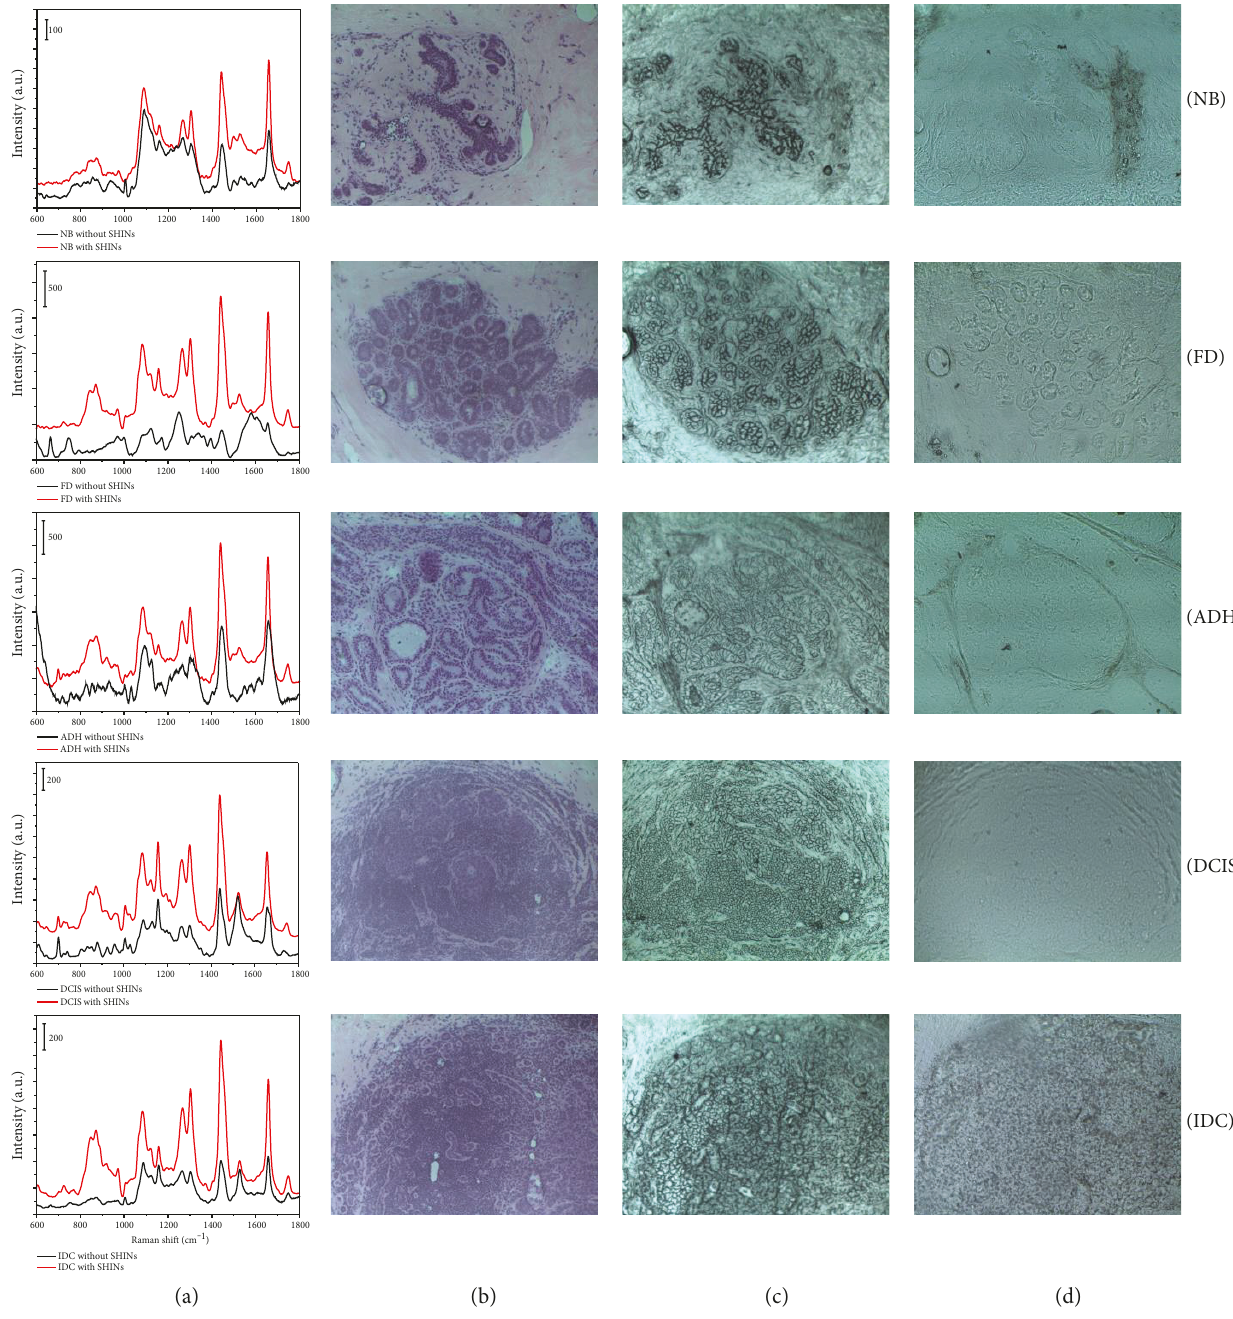
Figure 2: Diagnosis of breast cancer with Raman spectroscopy. (a) Mean Raman spectra and SHINERS spectra of breast tissues: normal breast (NB) tissues, fi broadenoma (FD), atypical ductal hyperplasia (ADH), ductal carcinoma in situ (DCIS), and invasive ductal carcinoma (IDC). (b) Corresponding images of frozen sections were stained with HE. (c) Corresponding images of frozen sections without shell-isolated nanoparticles (SHINs). (d) Corresponding images of frozen sections with SHINs. The images show an area of 0.8 × 0.6mm 2 [24,